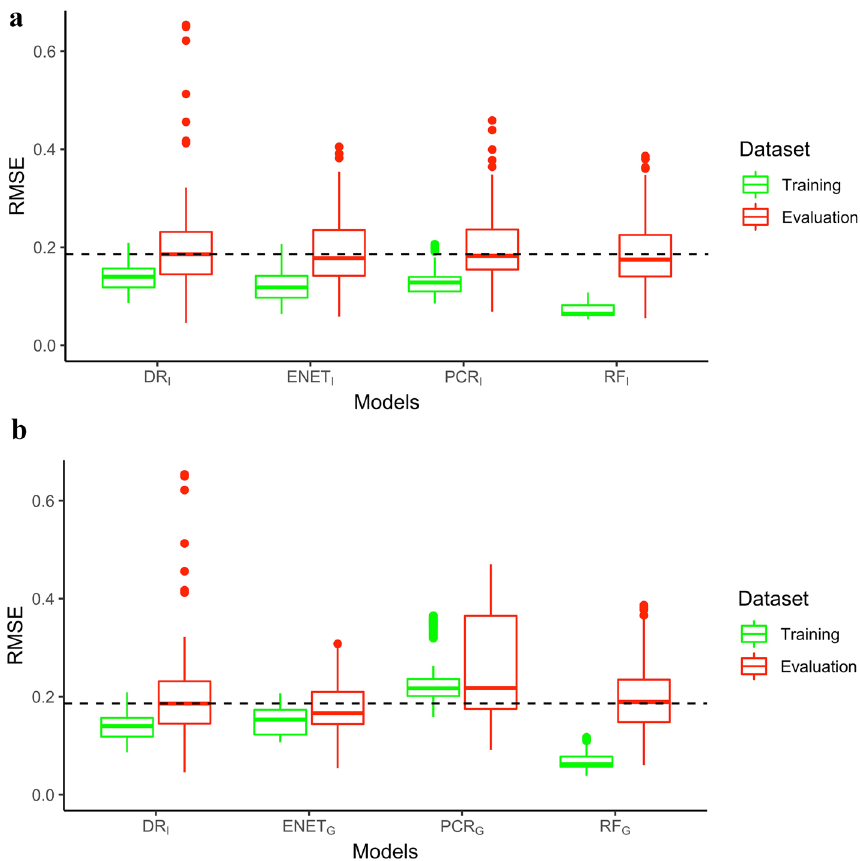
Figure 2. Distributions of models’ performance. ( a ) RMSE distributions of each individual models and ( b ) the models computed on the whole group. Within boxplot midline represents the median of the distribution. All of them are compared to the dose-response (DR)